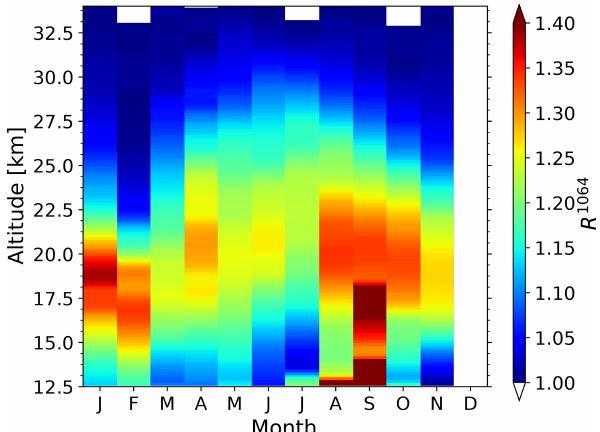
Figure 10. Monthly mean aerosol backscatter ratio R 1064 from 208 measurement runs from 2014 to 2017. The dataset contains night and daytime measurements, and it includes a total of